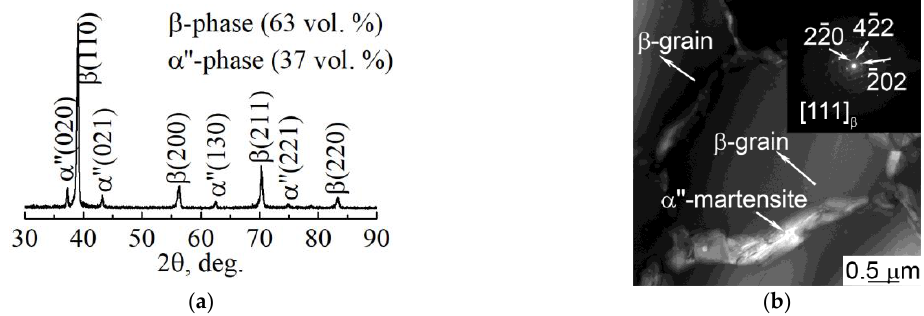
Figure 8. ( a ) XRD pattern and ( b ) TEM light-field with corresponding SAED pattern of LPBF porous sample.